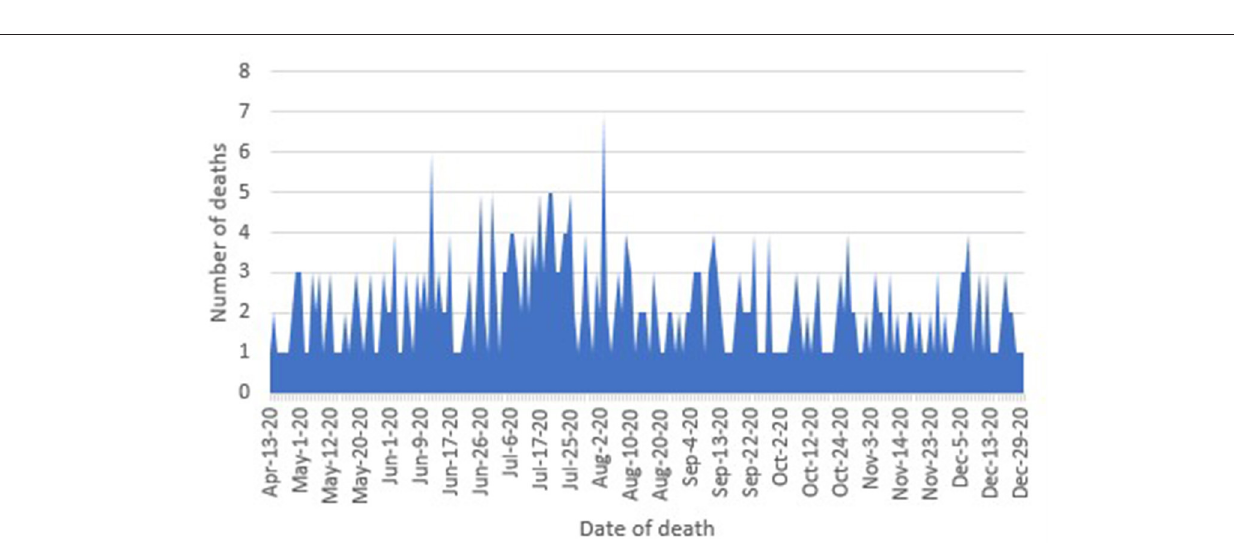
FIGURE 2 | Curve by date of death in COVID-19 confirmed cases. Source: General Directorate of Epidemiology